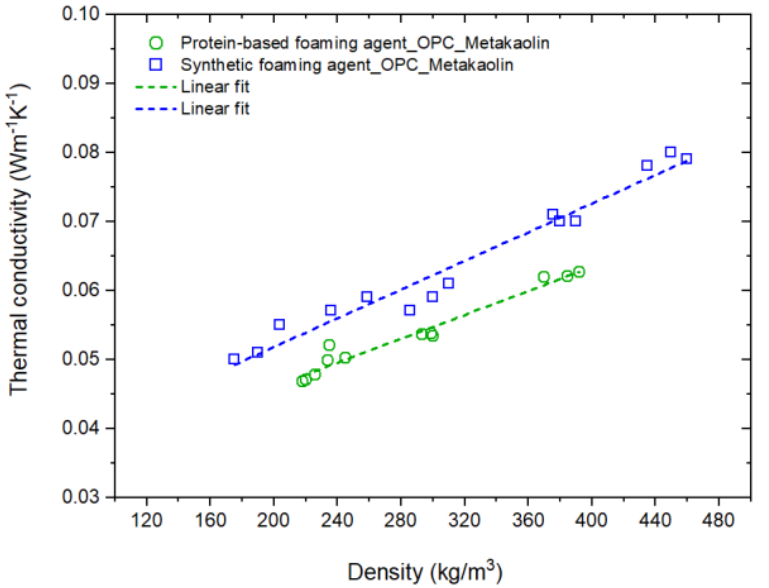
Figure 16. Thermal conductivity of foam concrete made of OPC with synthetic or protein-based foaming agent.